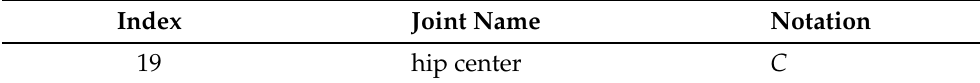
Table A2. Auxiliary